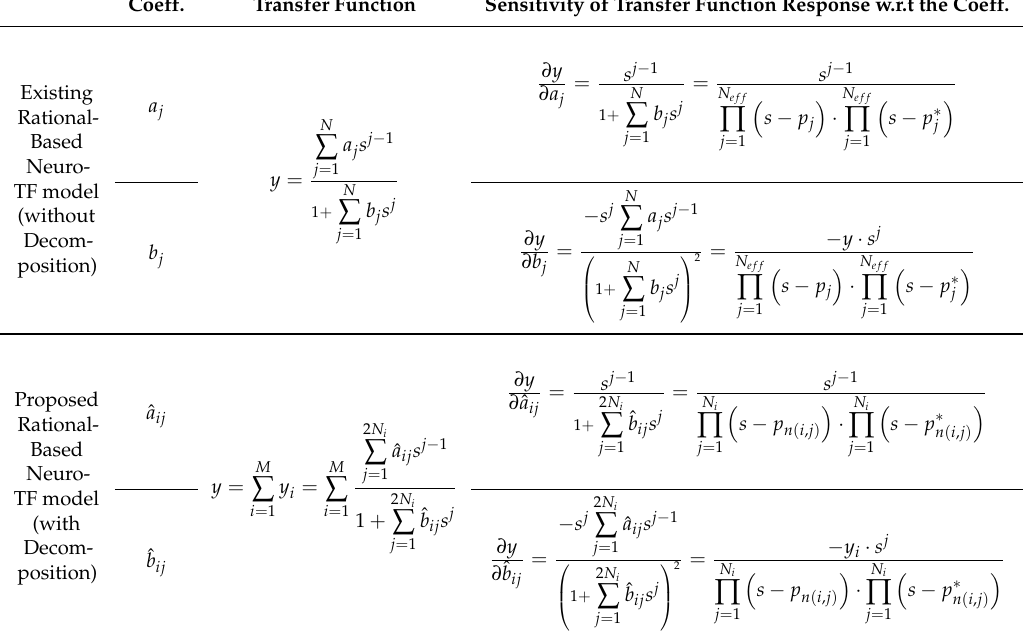
Table 1. Comparison of the sensitivity of rational-based neuro-transfer function (neuro-TF) model response with respect to the coefficients with/without decomposition. Coeff. Transfer Function Sensitivity of Transfer Function Response w.r.t the